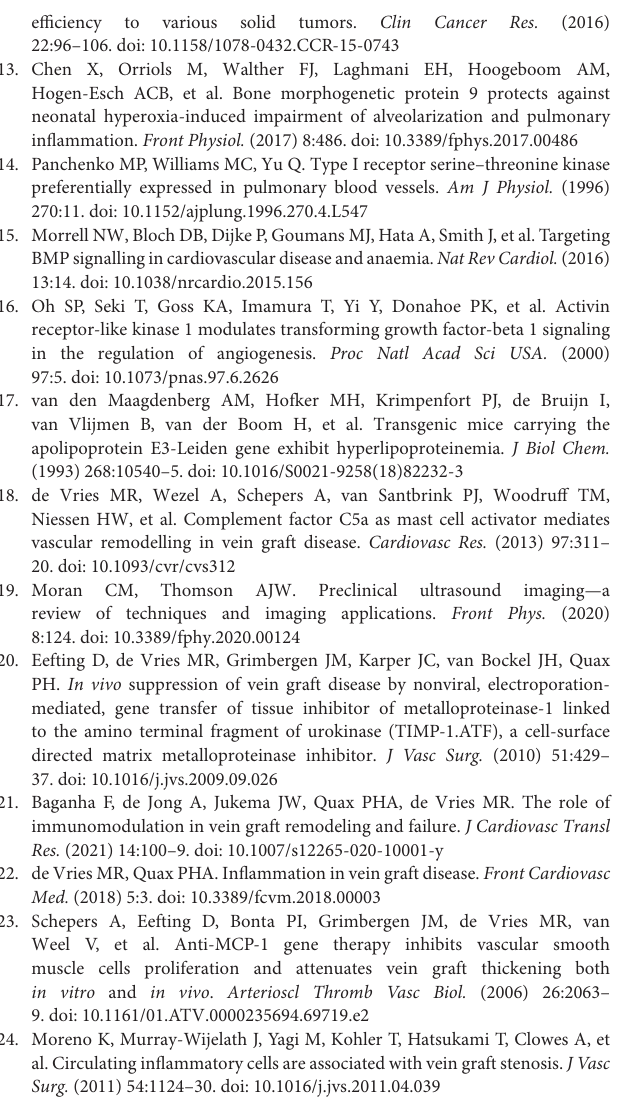
Supplementary Figure 1 | mRNA expression levels of genes involved in TGF- β /BMP signaling. Total RNA was isolated from ALK1-Fc treated ApoE3 ∗ Leiden mice ( n = 6) and control-Fc treated ApoE3 ∗ Leiden mice ( n = 6). The mRNA expression levels of genes involved in TGF- β /BMP signaling were assessed by qPCR. Statistical evaluation was performed with the unpaired parametric T -test, ∗ p < 0.05, ∗∗ p <